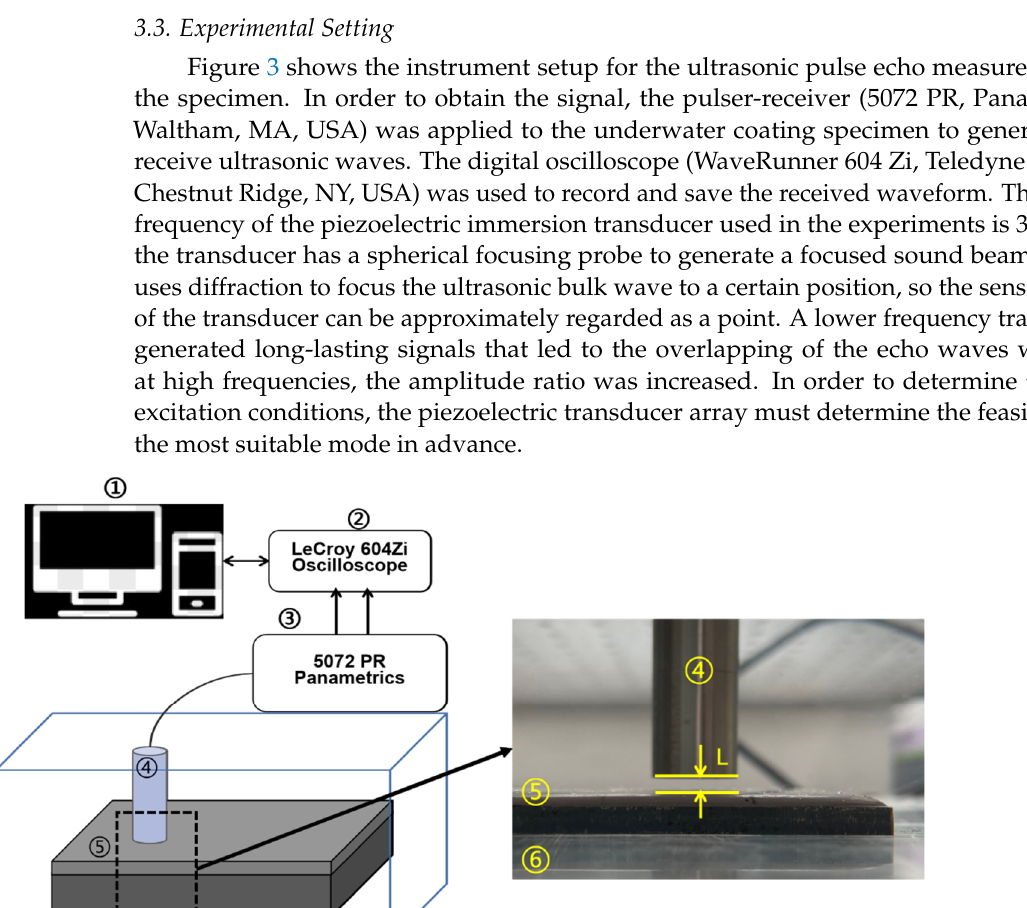
Figure 2. Optimal suitable area for experimentation was selected from the manufacturing specimen of the coating: 20th and 21st.